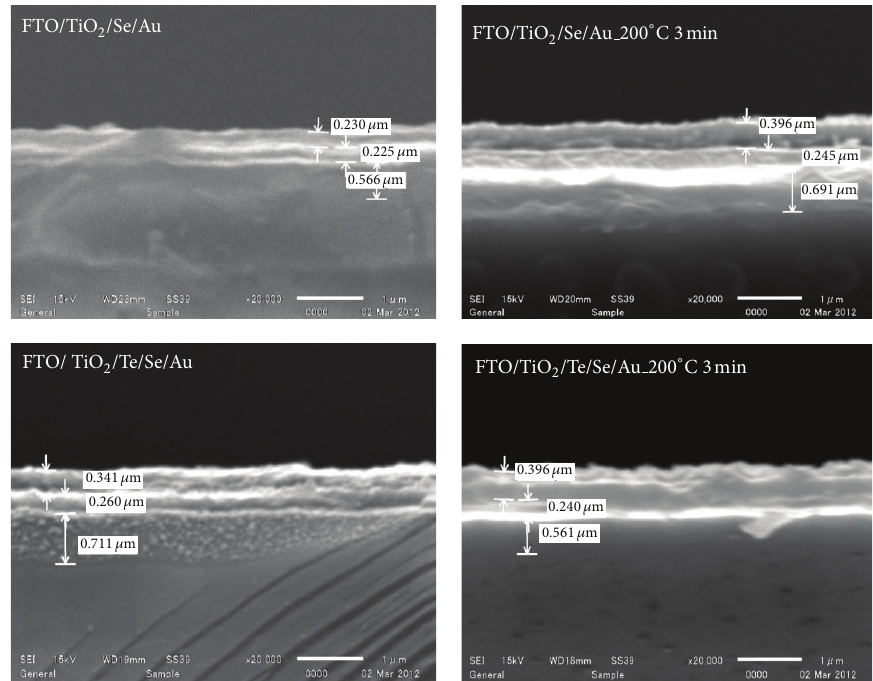
Figure 3: SEM pictures of the cross-sections of selenium-deposited electrodes with and without tellurium and before and after annealing at 200 ∘ C for 3 min.